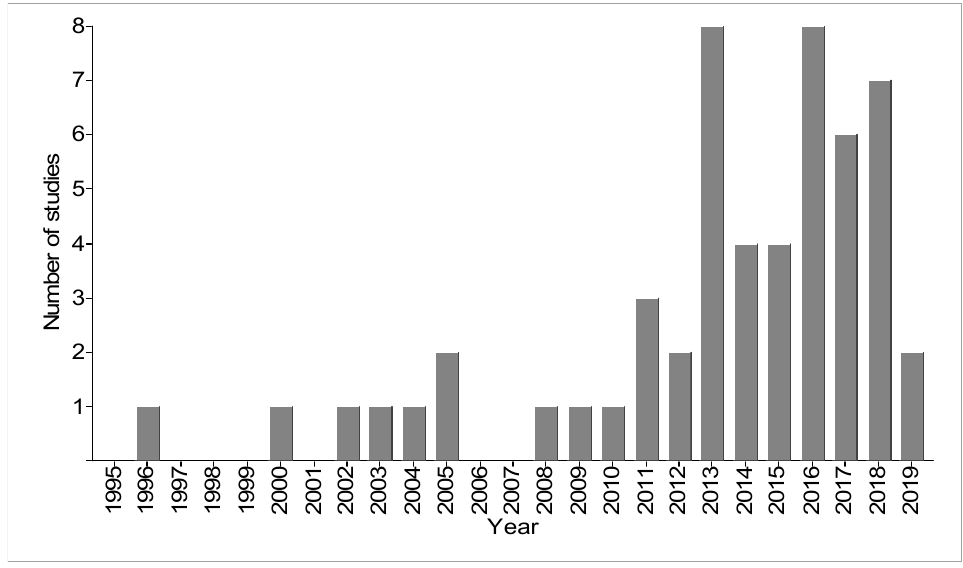
Figure 3. Number of studies between 1995 and August 2019.